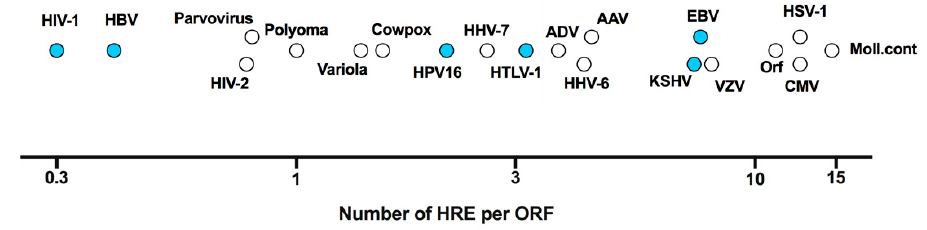
Figure 2. Frequency of HIF response elements (HRE) in viral DNA genomes. The frequency of HRE elements (RCGTG) is plotted against the number of open reading frames (ORF) for a range of DNA viruses with those marked in blue discussed in this review. Referent sequences presented were selected from Genbank as follows (accession numbers in brackets); adeno-associated virus (AAV, NC_001401.2), adenovirus (ADV, AC_000007.1), cytomegalovirus (CMV, KU317610.1), cowpox virus (CowPox, NC_003663.2), Epstein–Barr virus (EBV, NC_009334.1), hepatitis B virus (HBV, NC_003977.2), human herpesvirus 6 (HHV-6, NC_000898.1), HHV-7 (NC_001716.2), Kaposi’s